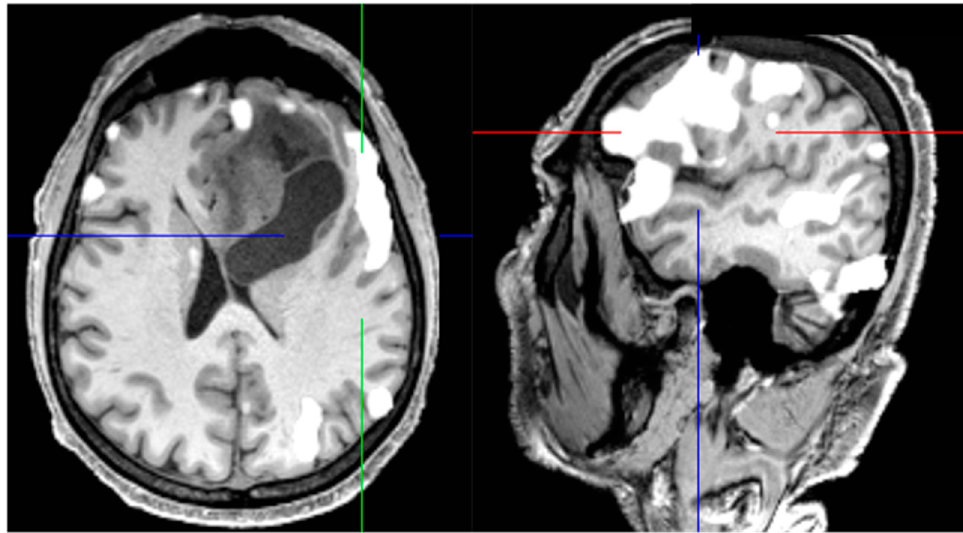
Figure 5. fMRI language task in a patient with high-grade glioma shows Broca’s area clearly lateral- ized to the left side.